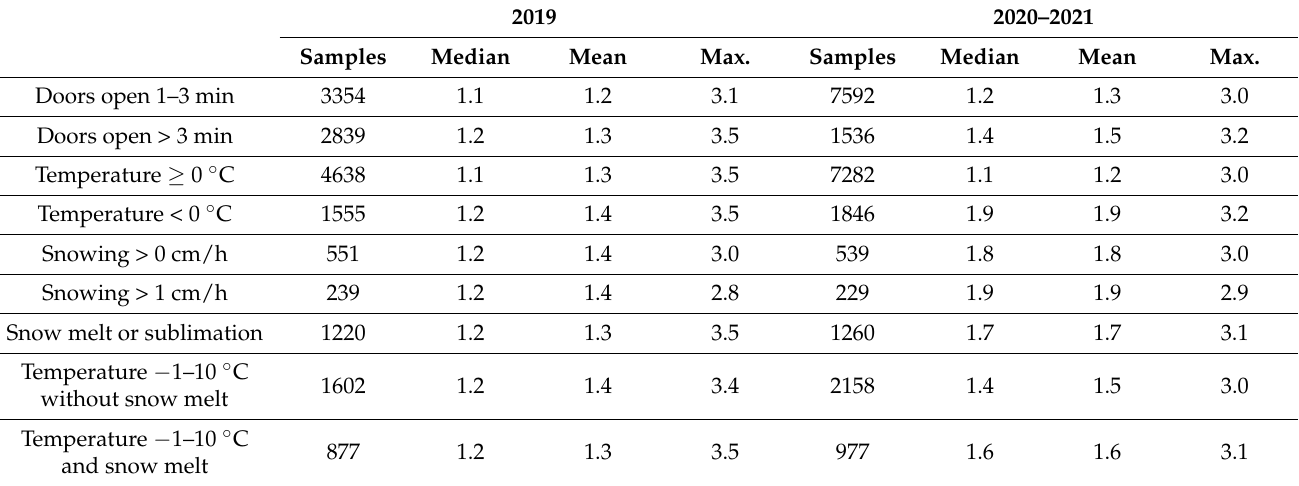
Table 1. Energy consumption (kWh/km) for specific